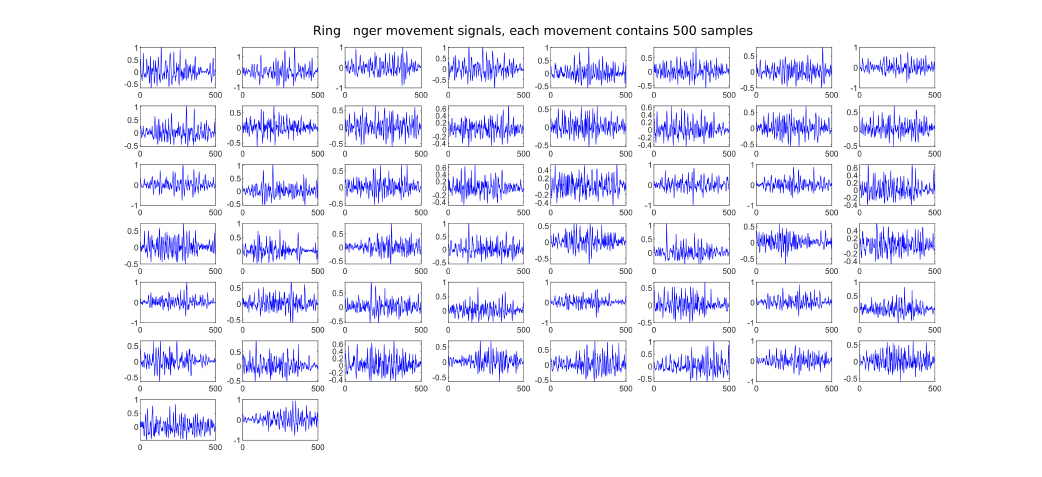
Figure 15. Signals with the windowing process obtained from each movement to be characterized.